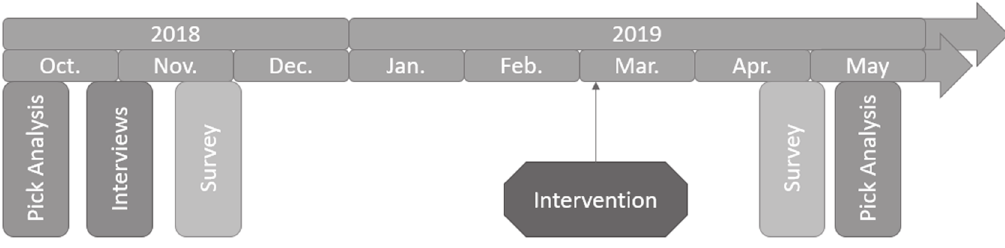
Figure 2. Timeline of the research project.